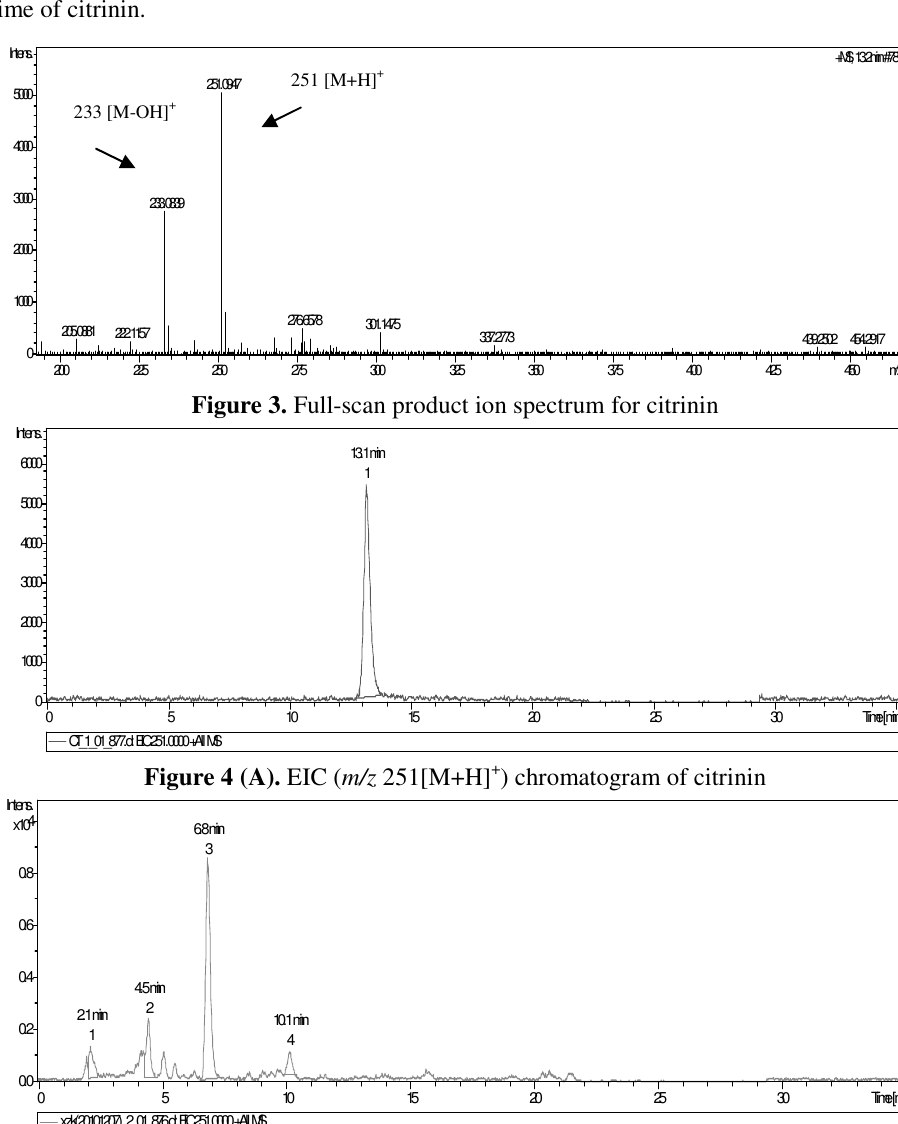
Figure 4 (B). EIC ( m/z 251[M+H] + ) chromatogram of